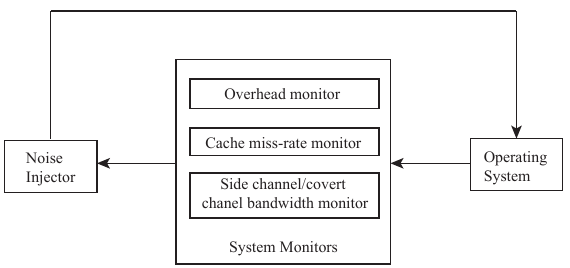
Figure 1. Defense Model Overview